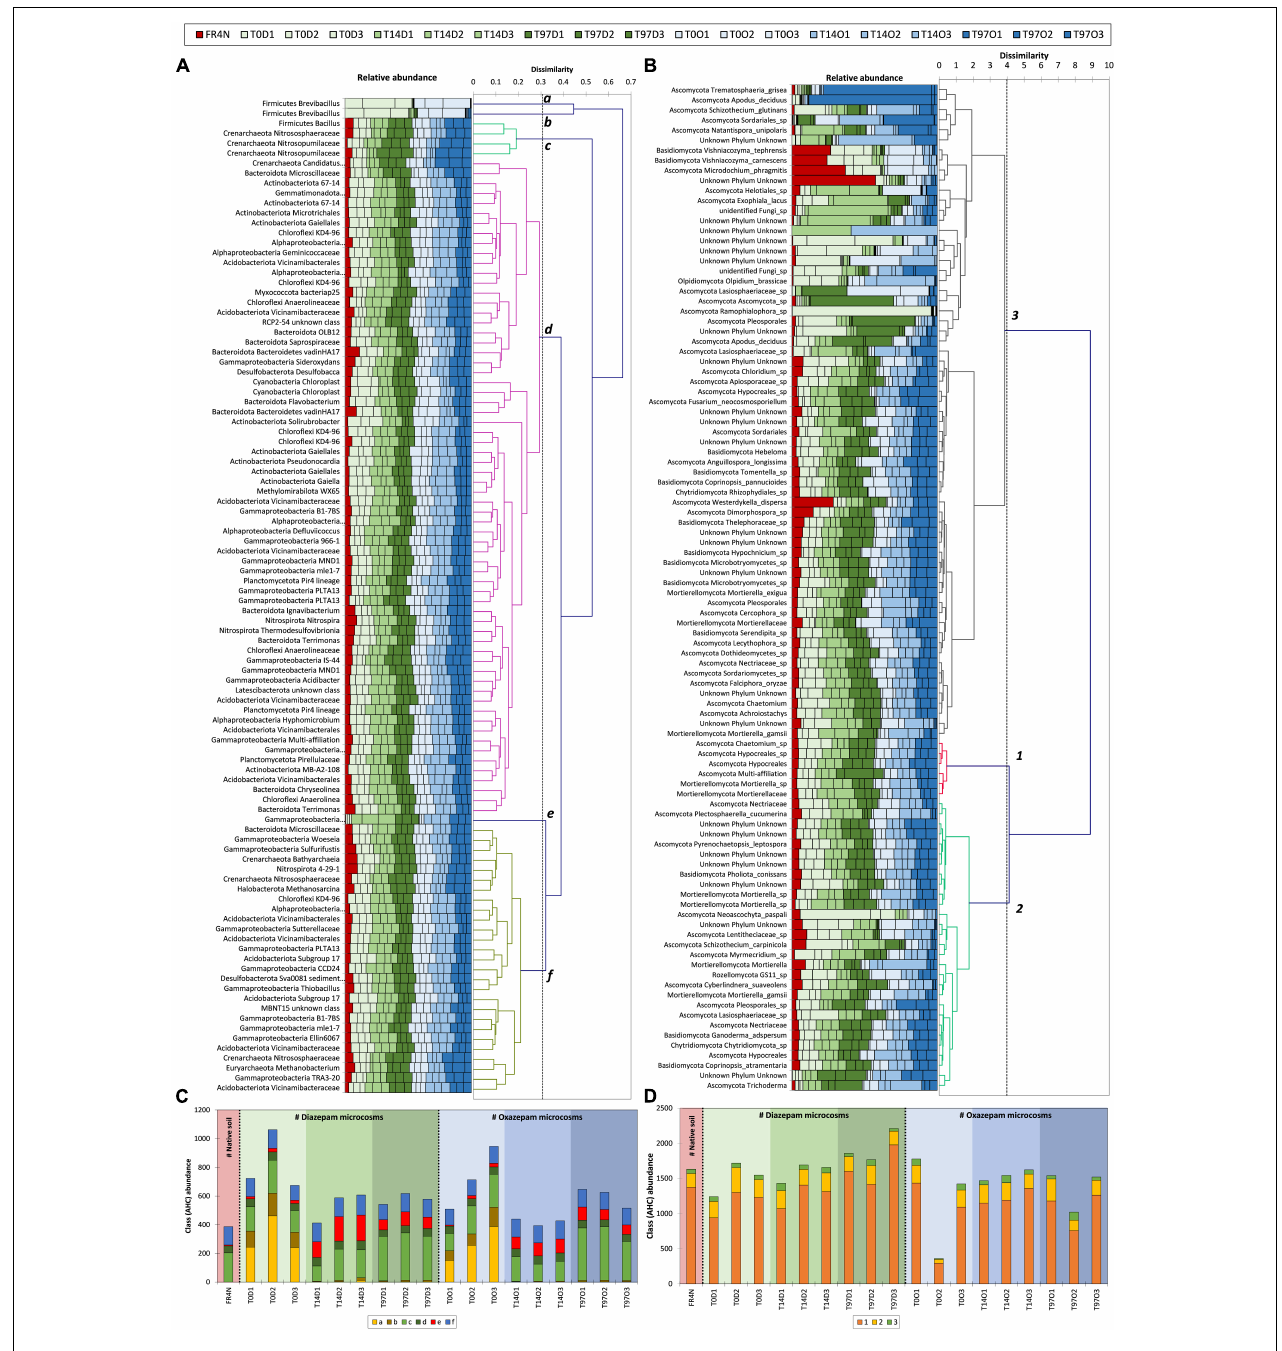
FIGURE 5 | Agglomerative Hierarchical Clustering evaluated from Bray–Curtis distances with proportional link as aggregation method for the 100 most abundant OTUs (sum on the 19 samples), for (A) bacterial and archaeal OTUs and (B) fungal OTUs. Panel (C) corresponds to the histogram presenting the repartition of the six different classes defined by AHC for bacterial and archaeal OTUs and (D) the three classed defined by AHC for fungal